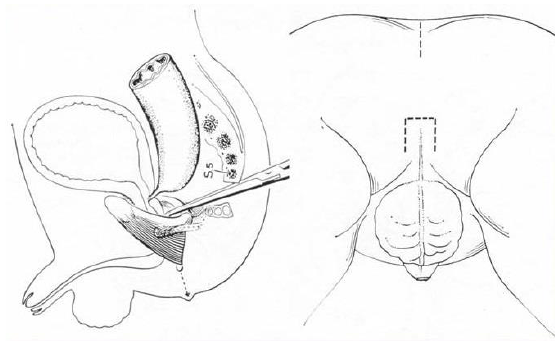
Figure 3: Stephen’s sacroperineal approach, 1953.